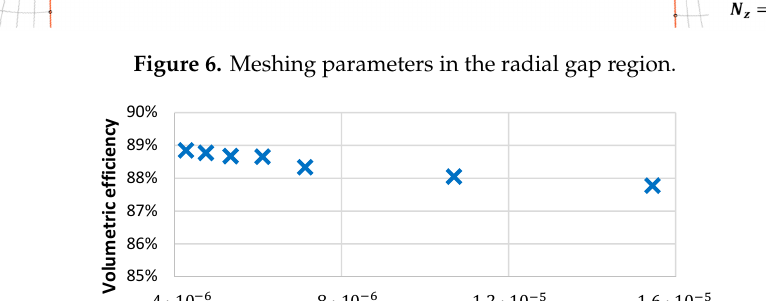
Figure 6. Meshing parameters in the radial gap region.